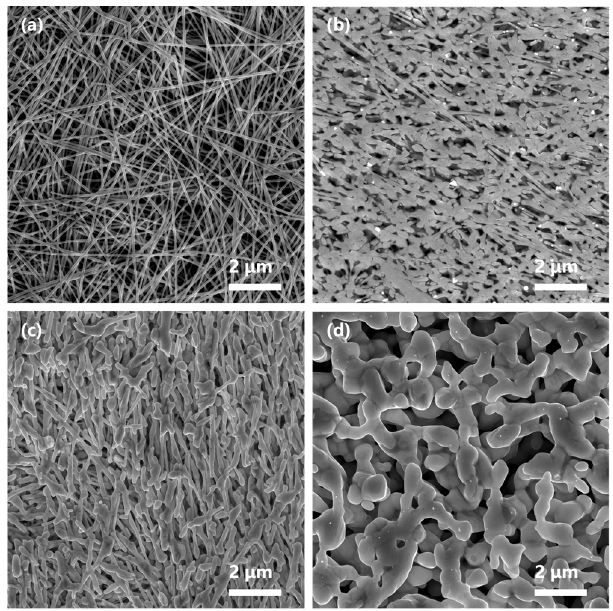
Figure 8. SEM images of silver nanowire film prepared with silver nanowire (1) sintered at different temperatures ( a ) 50 °C, ( b ) 200 °C, ( c ) 250 °C, ( d ) 300 °C.